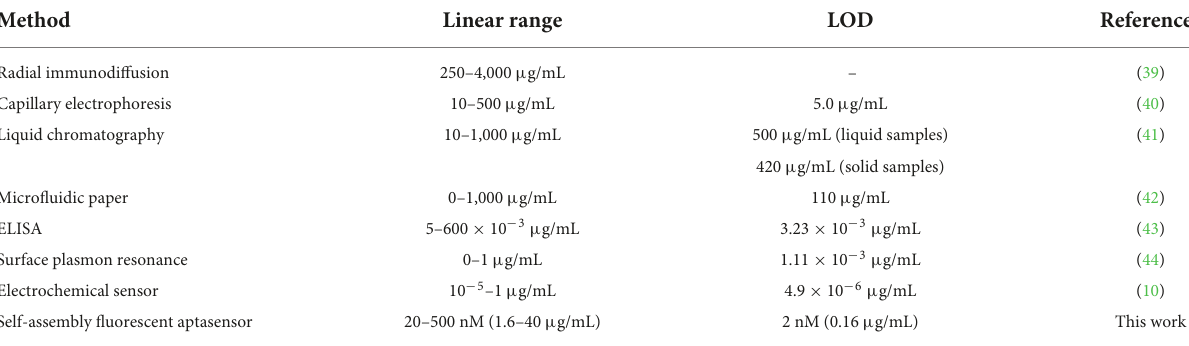
TABLE 2 Performance comparison of various methods for detecting